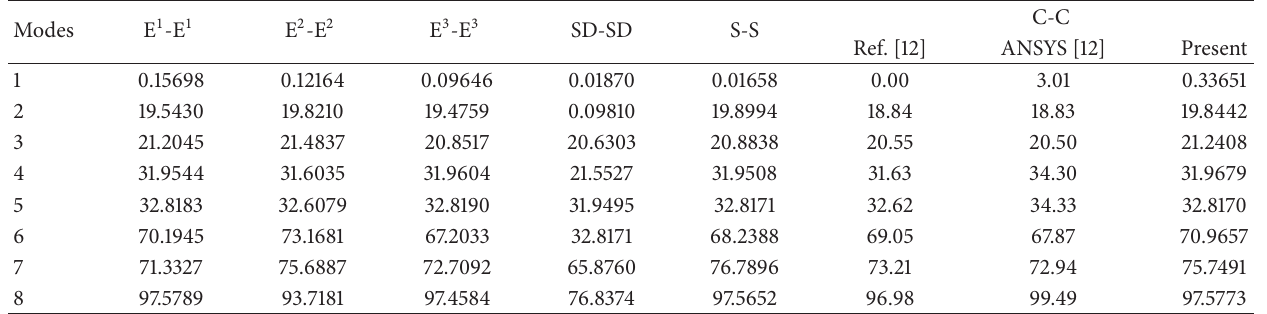
Table 17: First eight frequencies (Hz) for a closed cylindrical shell with single point clamped-supported at each end. Modes